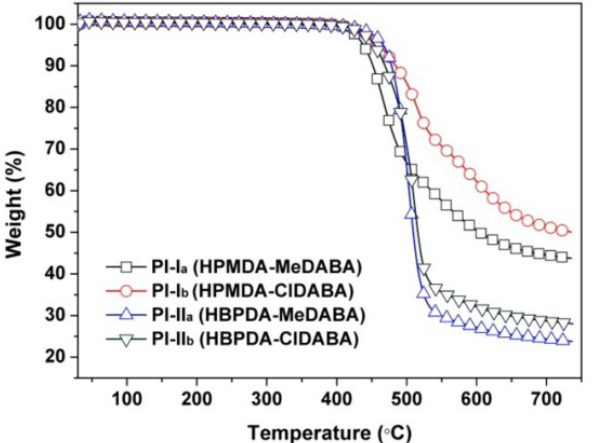
Figure 10. TGA curves of PI films in nitrogen.